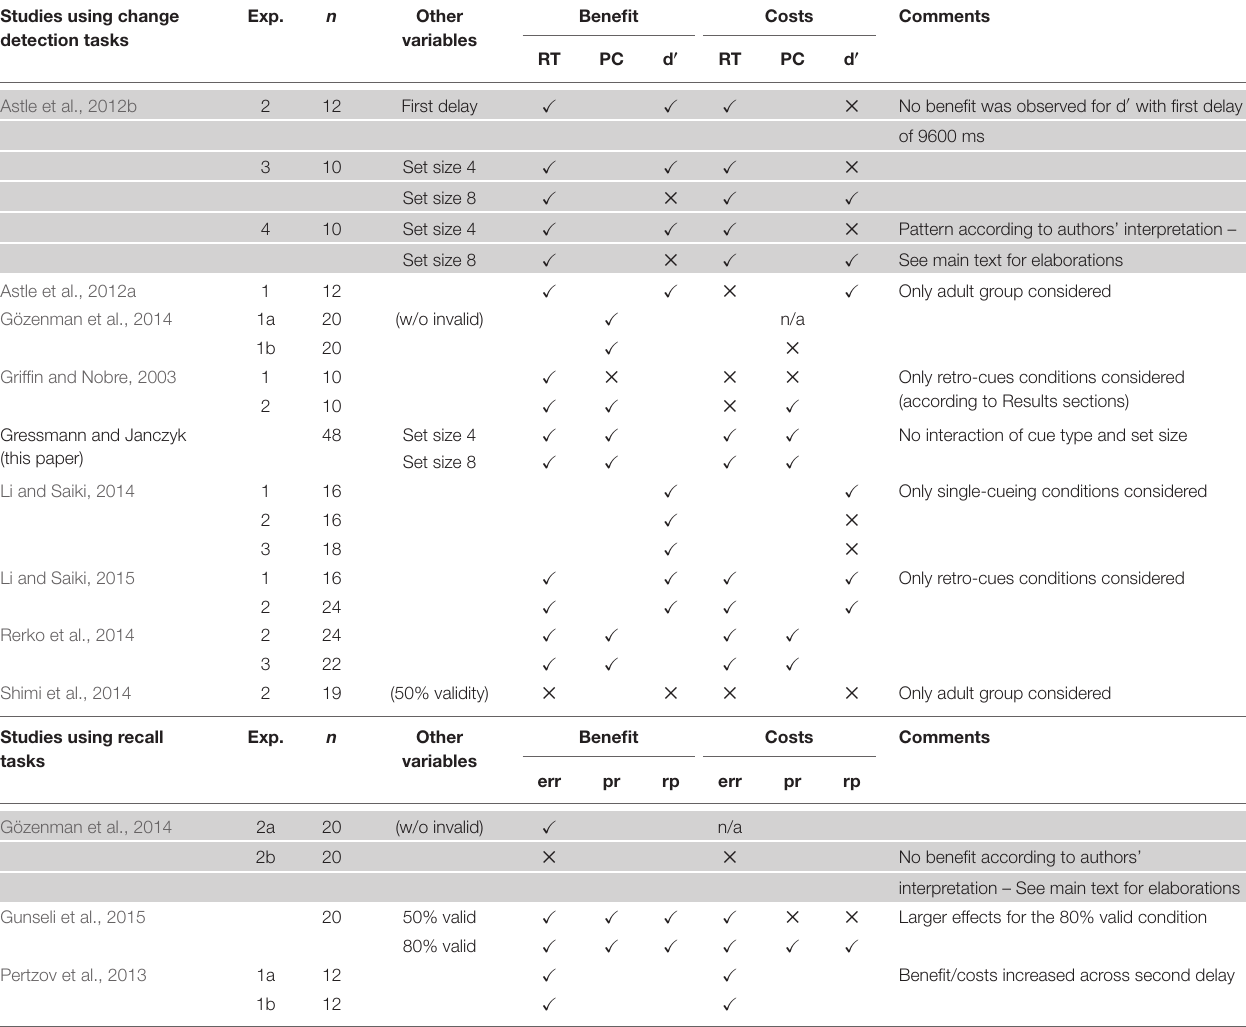
Benefits refer to the difference between valid and neutral/no-cue trials, costs indicate the difference between neutral/no-cue and invalid retro-cues. Note that the study by Matsukura et al. (2007) used invalid trials as well, but no neutral trials. Thus, it is not possible to assess costs and benefits separately. The gray shaded cells indicate the experiments that are discussed in detail in the main text. Benefits and costs for d (cid:48) in the study by Li and Saiki (2014) and for RTs and d’ in the study by Li and Saiki (2015) were significant according to personal communication with the authors. n = size of actually analyzed sample; PC, percent correct; RT, response time; err, raw angular error; pr, precision; rp, recall probability; w/o, without; n/a, not